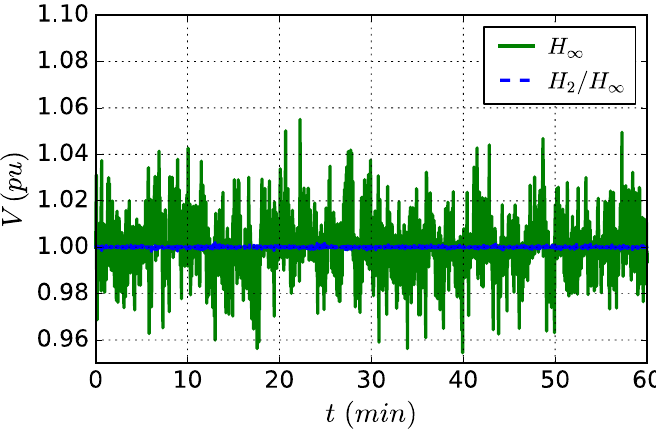
2 / H ∞ control and H ∞ control methods.